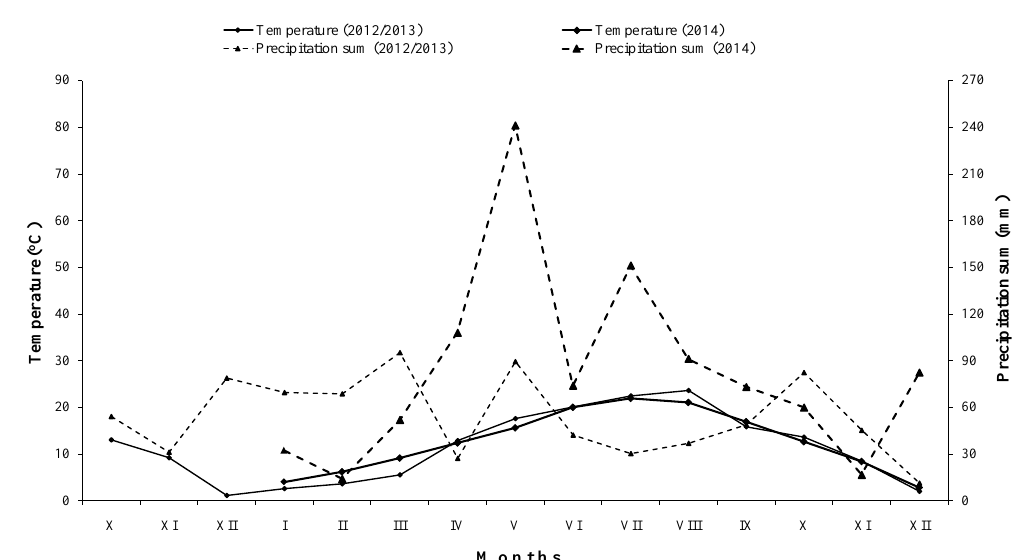
Figure 1. Temperatures and precipitations developments for wheat and maize vegetation period in 2012 / 2013 and 2014, respectively, for the field study locality.